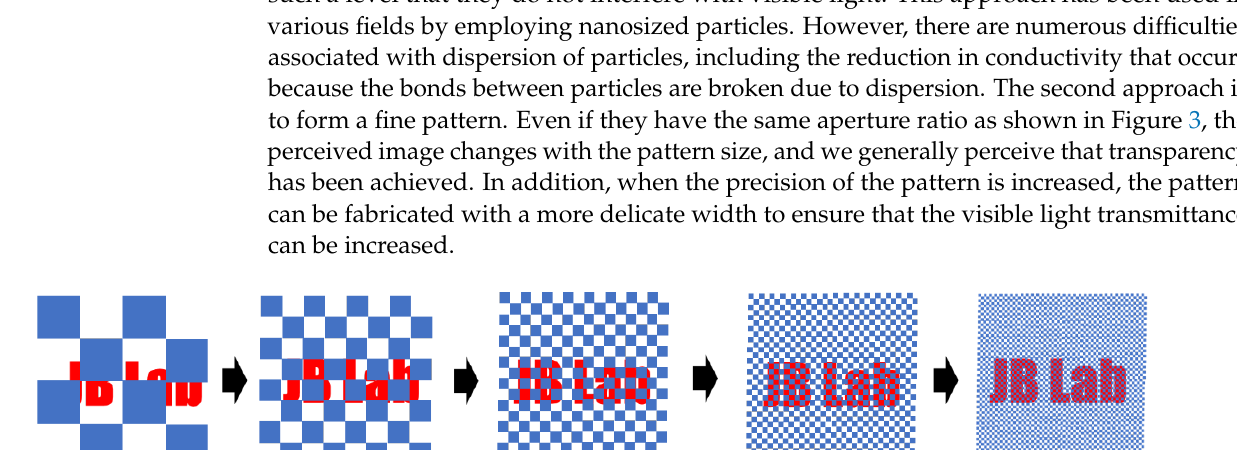
Figure 5. Enlarged image of the film patterned via imprinting. ( a ) Top view with ×100. ( b ) Sectional view with ×200.